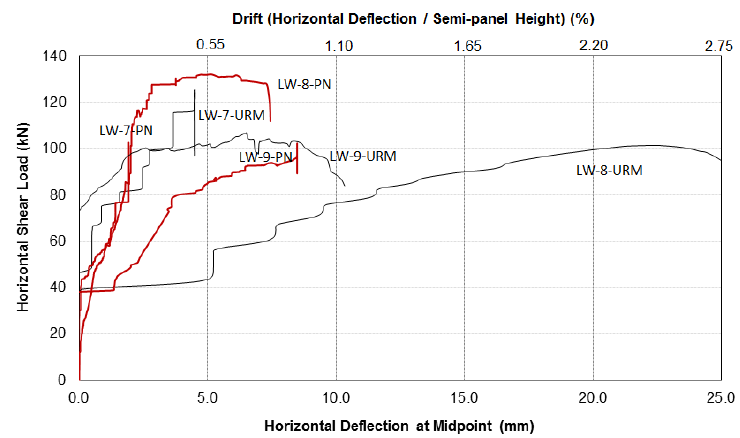
Figure 23. Total shear load versus horizontal deflection / drift (black lines: URM panels, red lines: repaired with PN).